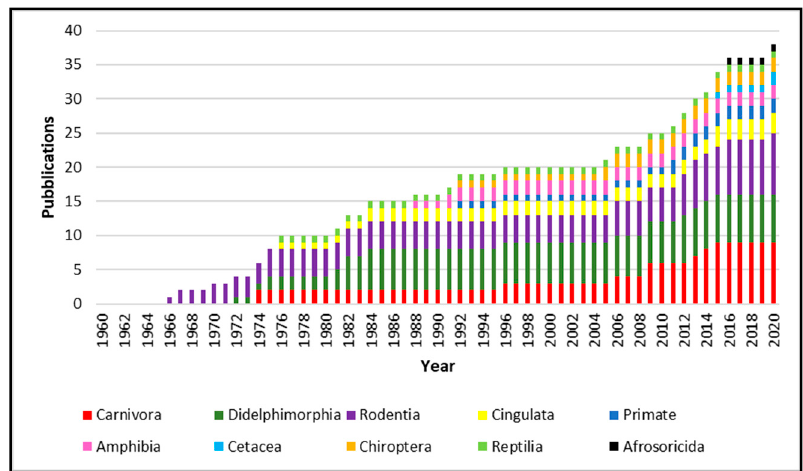
Figure 1. Number of f publications from 1960 to 2020 concerning Leptospira isolation from “unconventional” hosts. Different animal orders are represented with different colors.